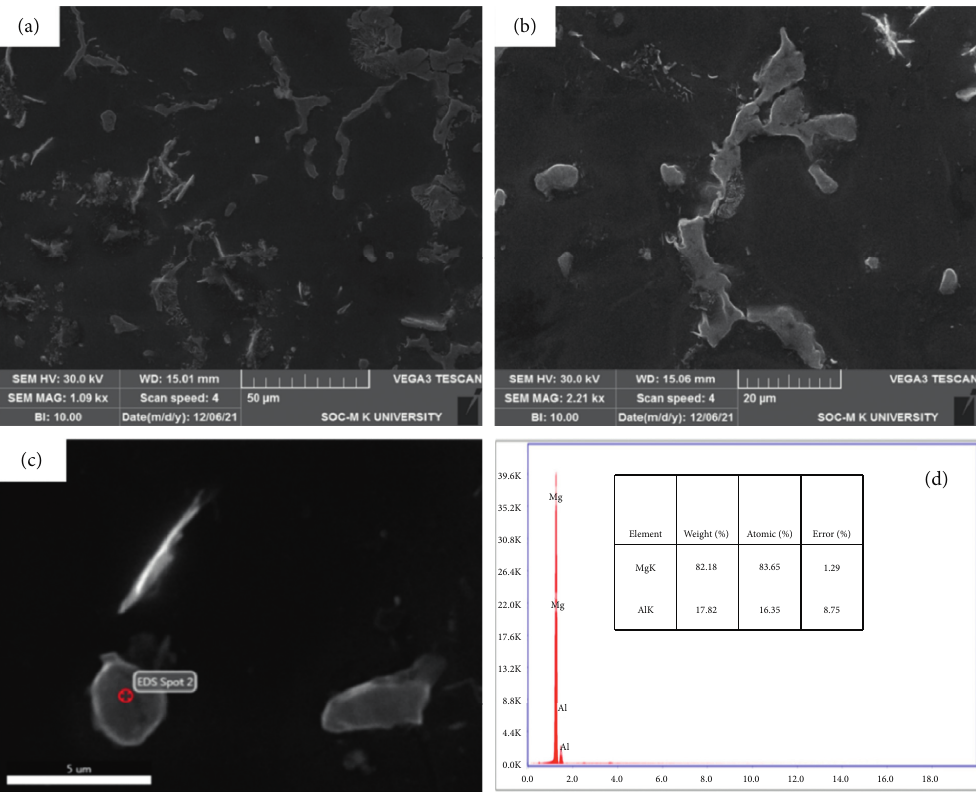
Figure 3: SEM and EDX Analysis of AZ91D alloy.